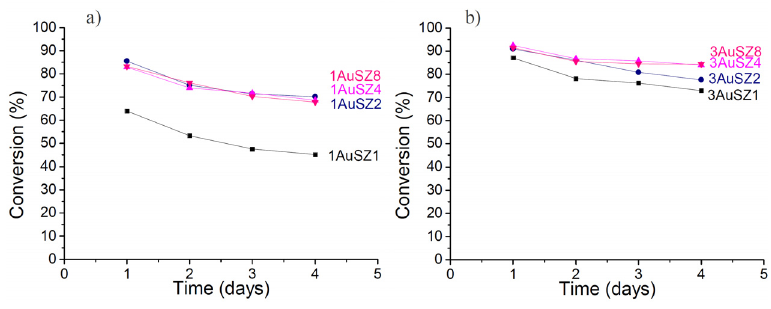
Figure 3. Conversion obtained for the LT-WGS reaction at 453 K for the 1 wt%Au ( a ) and 3 wt% Au ( b